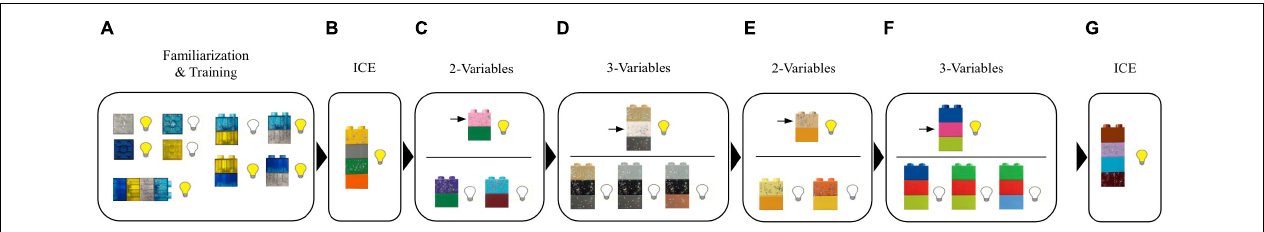
FIGURE 1 | Materials and an example of the testing procedure. Yellow (dark gray) lightbulb indicates the box lit up when the corresponding object was placed on it. White (light gray) lightbulb indicates the box did not light up when the corresponding object was placed on it. (A) Shows the bricks used in the familiarization and training, first individually and then in combination as shown. (B,G) Show the objects used in the ICE trials. In (C–F) , the initial stick is shown above the horizontal line, with the (X) focal brick indicated by an arrow. Below the horizontal line are the corresponding test choices that children could select. See Procedure for further